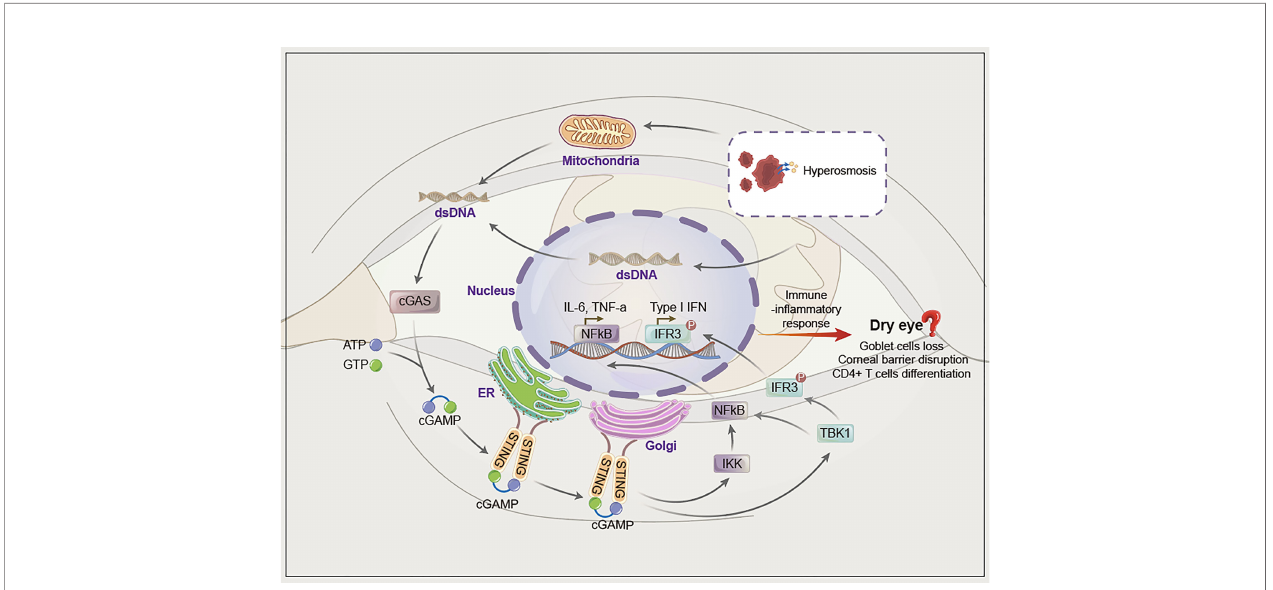
FIGURE 2 | The hypothesis of cGAS-STING pathway activation in dry eye. Hyperosmotic stress induces mitochondrial and nucleafr damage, after which dsDNA (mainly mitochondrial dsDNA) is damaged and released into the cytoplasm. Cytoplasmic dsDNA is recognized by cGAS, which converts ATP and GTP into cyclic GMP-AMP (cGAMP) and activates STING. STING migrates from the endoplasmic reticulum to the Golgi apparatus and initiates in fl ammation via phosphorylation downstream of TBK1/IRF3 and NF- k